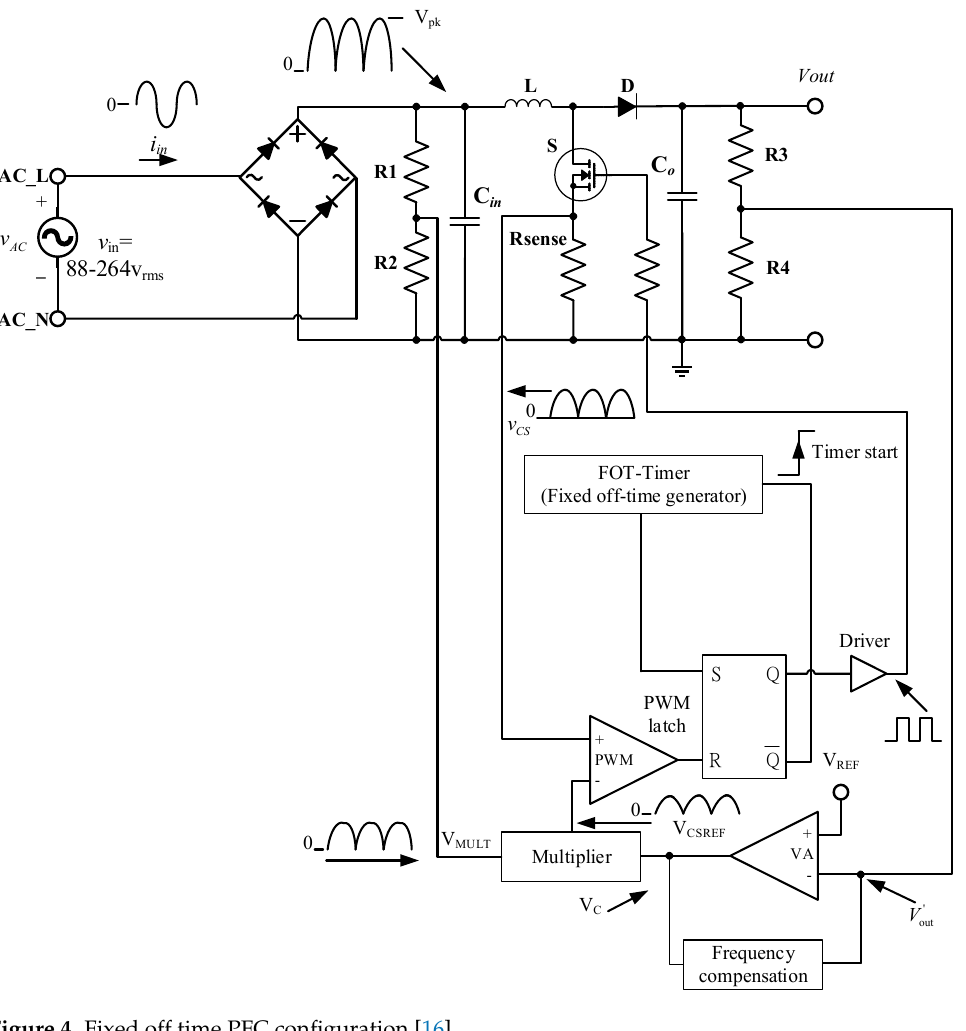
Figure 4. Fixed off time PFC configuration [16].